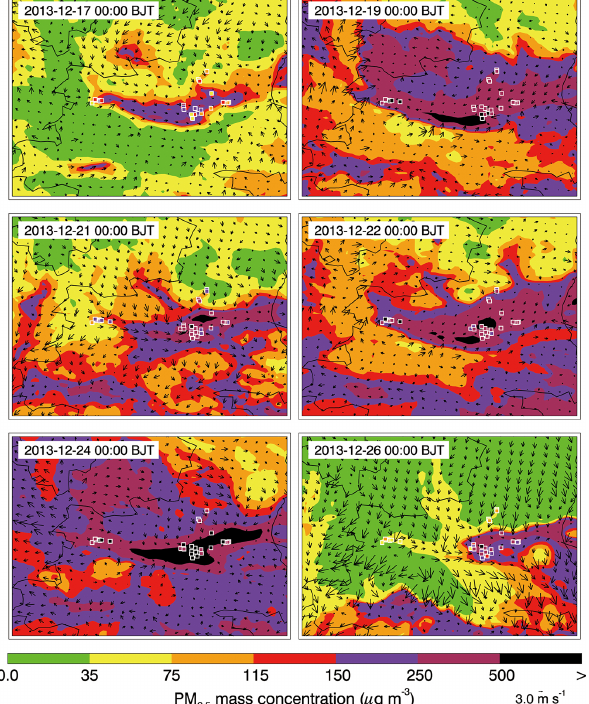
Figure 8. Same as Fig. 7, but in BTH from 13 to 21 January